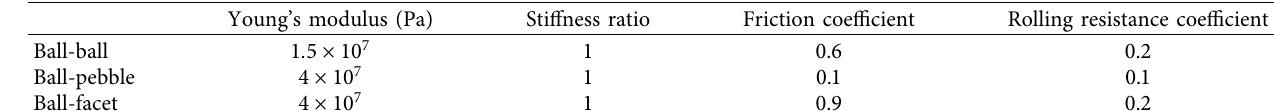
Figure 9: Different friction coefficients in different contacts. Table 1: Summary of contact model parameters.